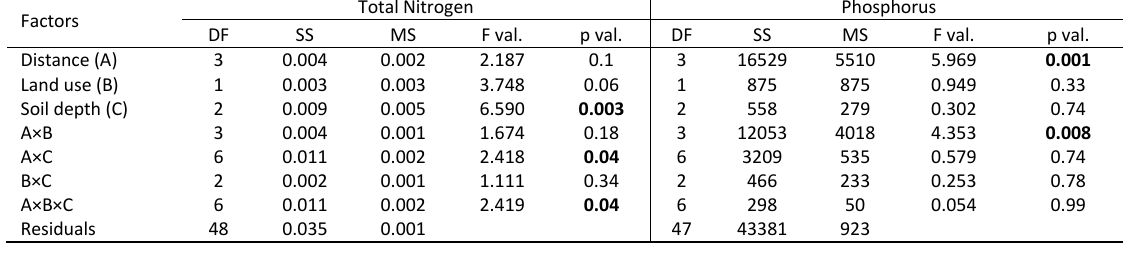
Table 3: Three way analysis of variance table for soil TN and P on distance (km) from the coast, land use type (agriculture vs. fallow land) and different soil depth. Significant differences are marked in bold in the table (α=0.05)